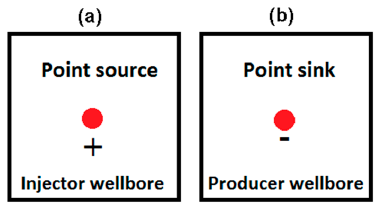
Figure 2. ( a ) Point source, ( b ) point sink. Adapted from Weijermars and Van Harmelen [79].